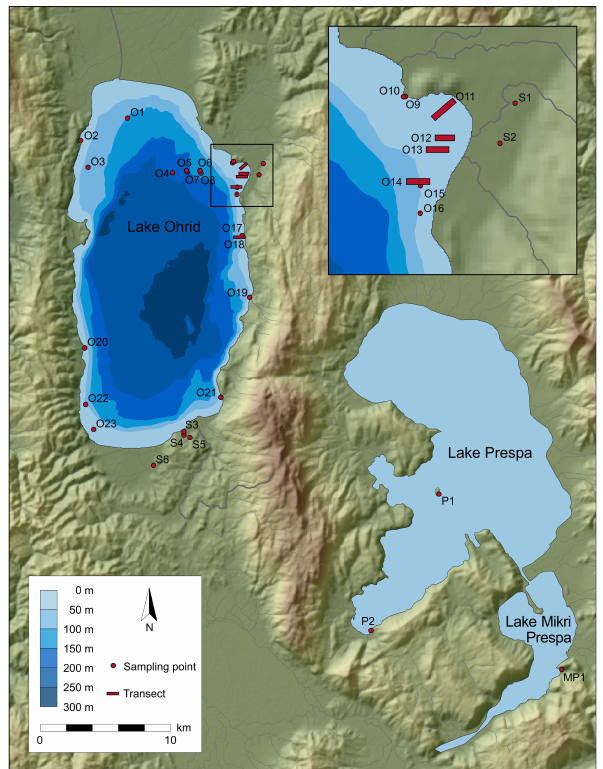
Fig. 2. Map of the Balkan lakes Ohrid, Prespa, and Mikri Prespa showing collecting sites for specimens of the family Erpobdelli- dae. The insert in the upper right corner shows an enlargement of the Ohrid Bay together with the respective collecting sites. Locality details are given in Table 1. Base map adapted from SRTM30 data (see http://eros.usgs.gov/#/Find Data/Products and Data